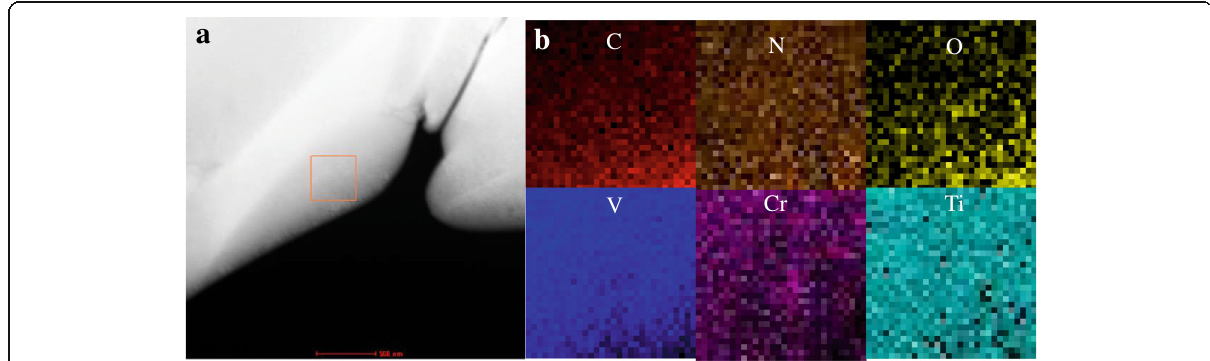
Fig. 5 STEM and EDS mapping of V-4Cr-4Ti alloys after post-irradiation annealing treatment at 450 °C for 30 h. a The low-magnification Z-contrast image. b The composition